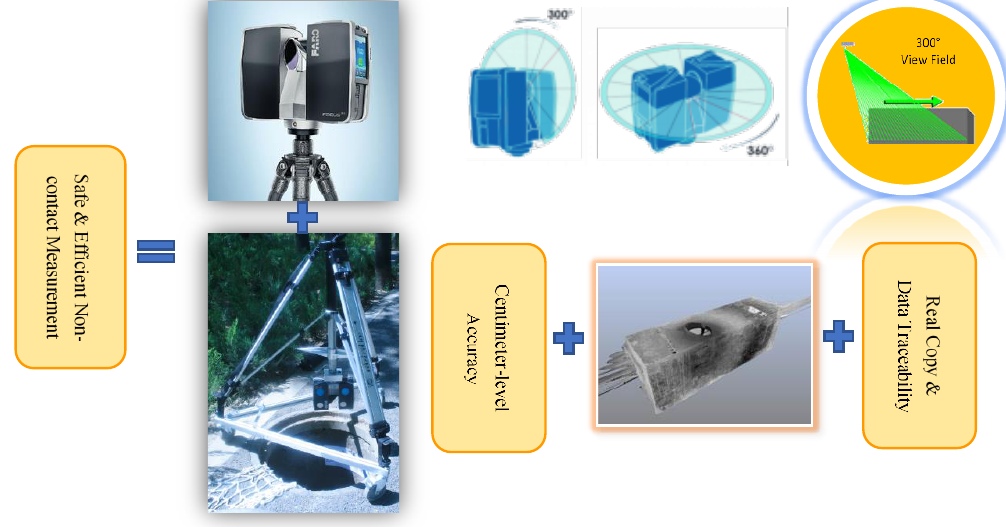
Figure 12. Experimental instruments and data acquisition.